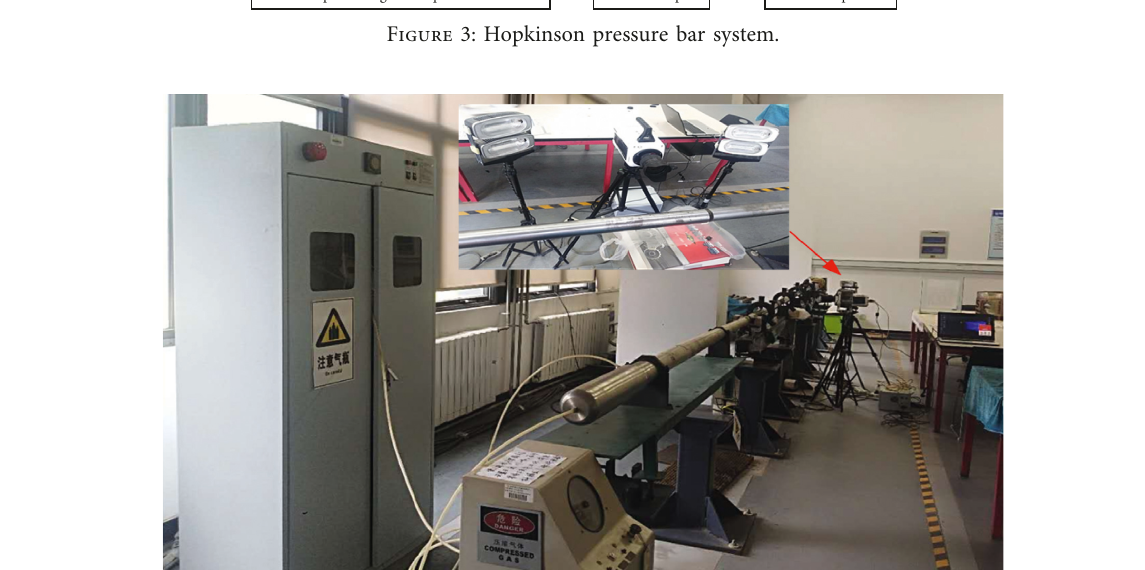
Figure 4: Hopkinson impact